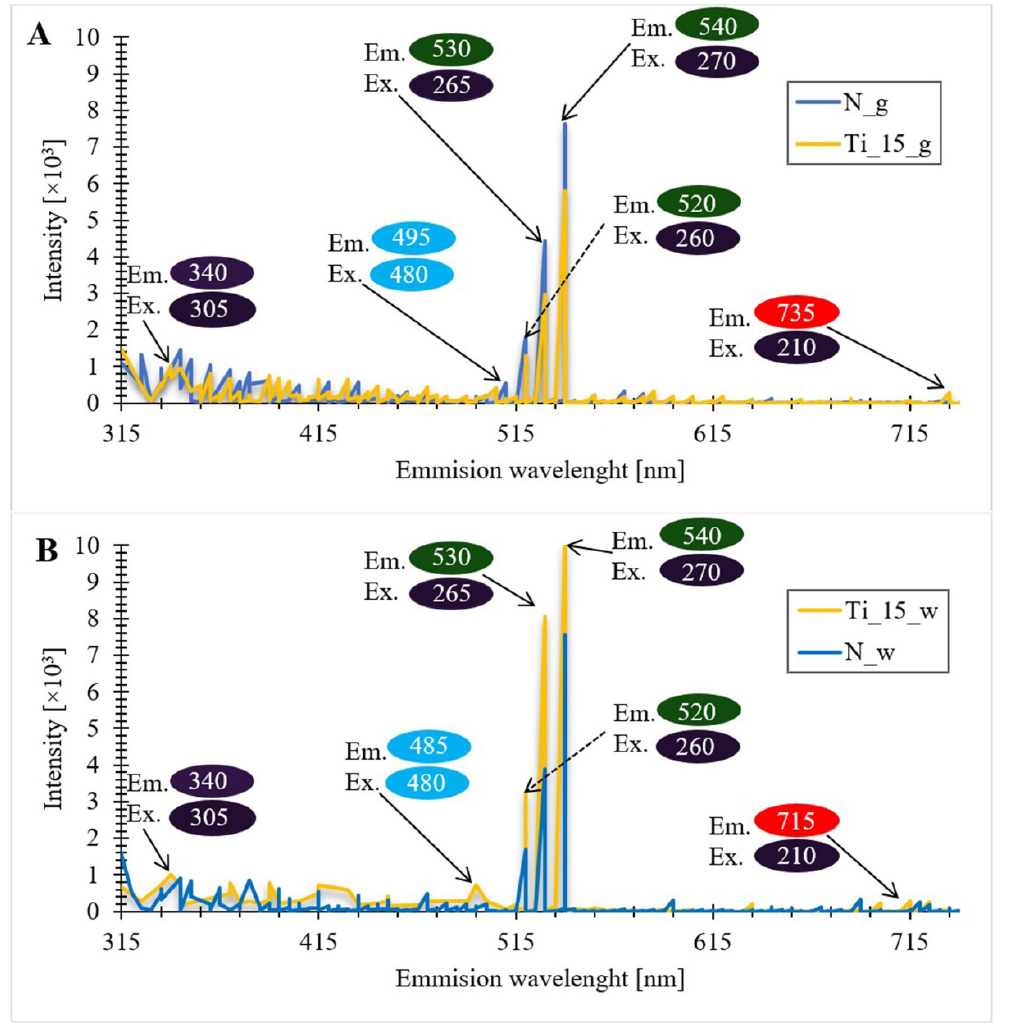
Figure 10. Photoluminescent spectra of undoped diatom biomass of the species Pseudostaurosira trainorii and biomass doped with titanium ions ( A ), as well as pure diatomaceous biosilica and biosilica doped with titanium ions ( B ) (N_g-undoped biomass; N_w-pure diatomaceous biosilica; Ti_15_g-the biomass doped with titanium ions with a concentration of 15 mg Ti/L; Ti_15_w-the biosilica doped with titanium ions with a concentration of 15 mg Ti/L).